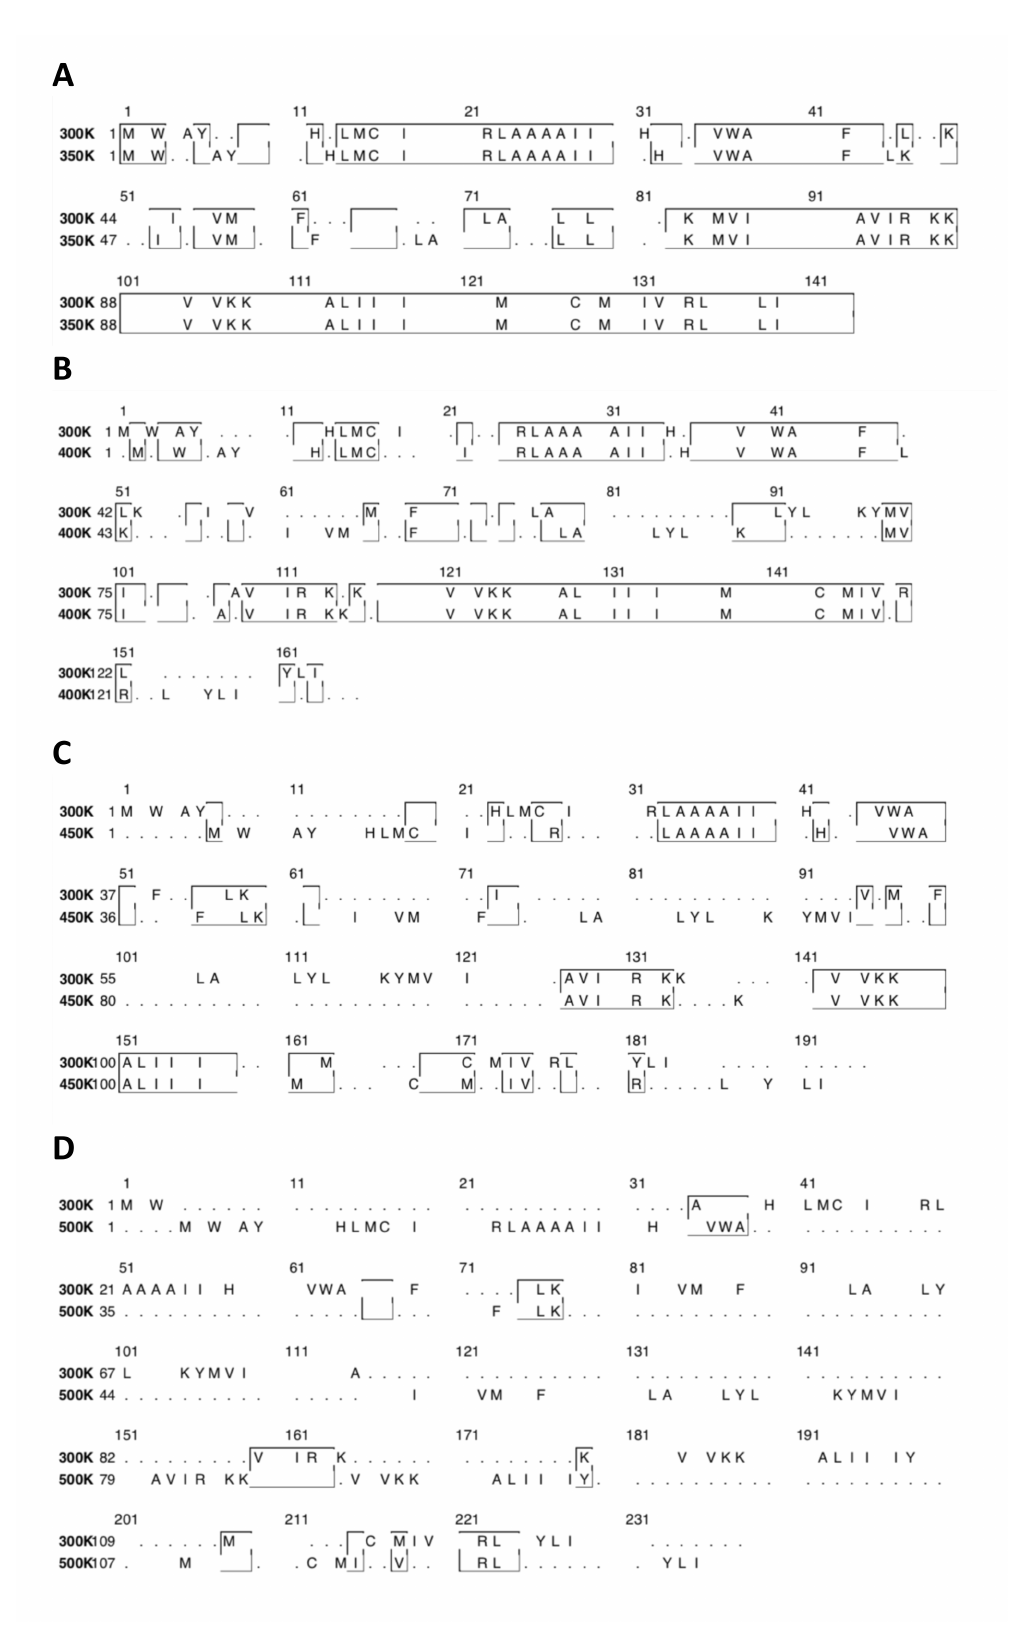
Figure 5. The alignment sequence of molecular structure was analyzed at a different temperature, with 300 K as a reference temperature. The box shows us the sequence conservation at different temperature as indicated by the letters ( A – D